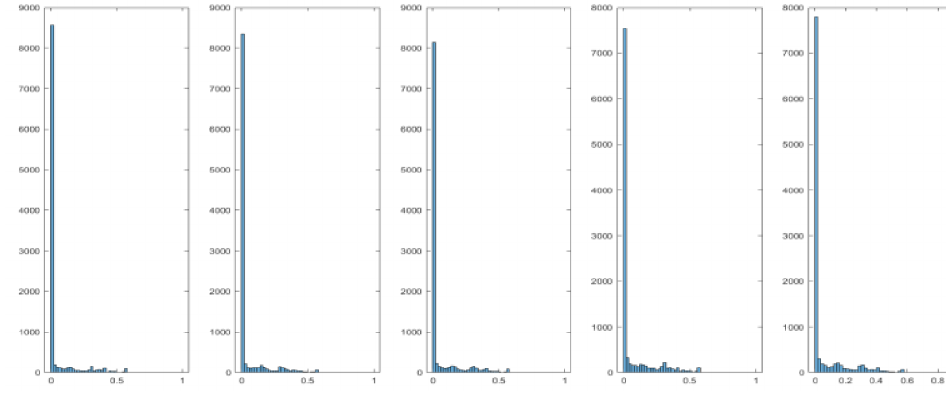
Figure 5. Intensity value-based Representation of HOG